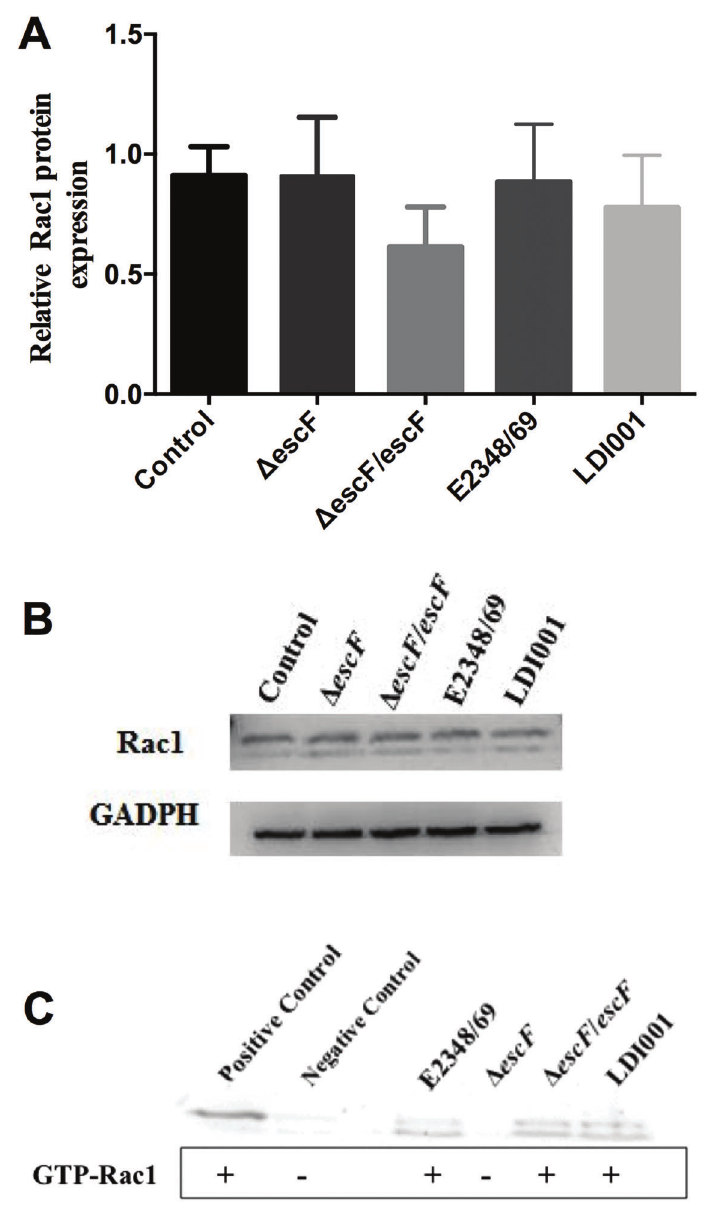
Figure 5. Enteropathogenic Escherichia coli (EPEC) strains E2348/69, EscF-complemented ( D escF/escF ) and T3SS-deletion mutant ( D escF ) infection did not affect protein expression of Rac1 in IEC-6 cells (western blot analysis) ( A and B ). EPEC strains, except the type III secretion system (T3SS)-de fi cient strain, promoted Rac1 activation ( C ). Data are reported as means ± SE of three independent